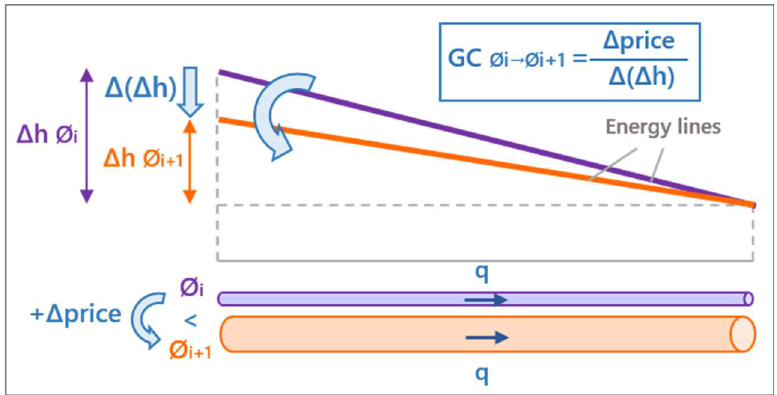
Figure 2. Change Gradient concept. Increasing the pipe’s diameter means a reduction in the head loss along the pipeline, but it has the extra cost of the wider and more expensive tube. The Change Gradient is the cost of reducing the head loss by 1 meter.